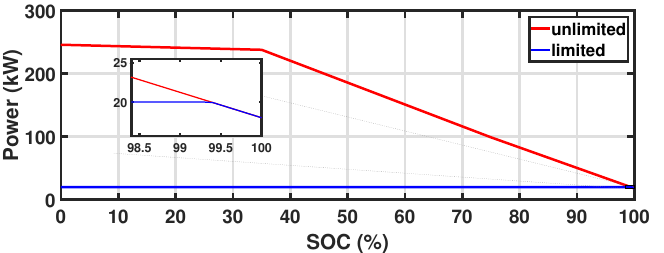
Figure A4. EV charging curve of a Tesla Model Y Performance [49] limited by 20-kW grid demand